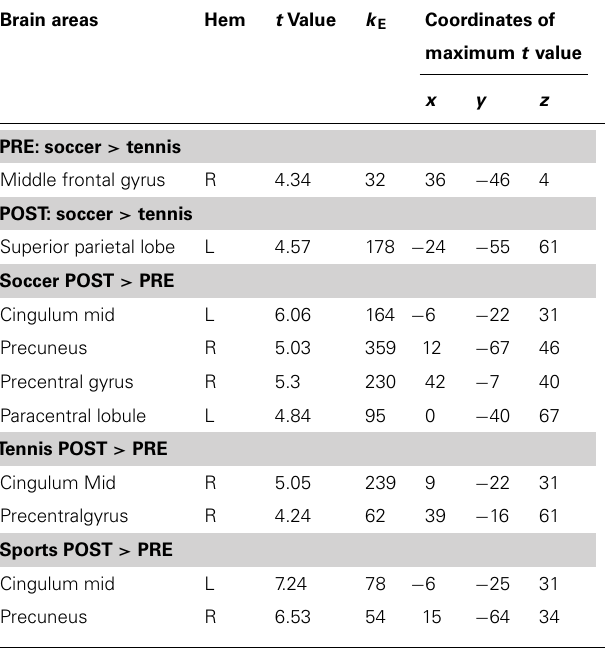
Table 1 | Coordinates of peak activation during Imagery of Soccer and Tennis before (PRE) and after (POST) sports exercise. Brain